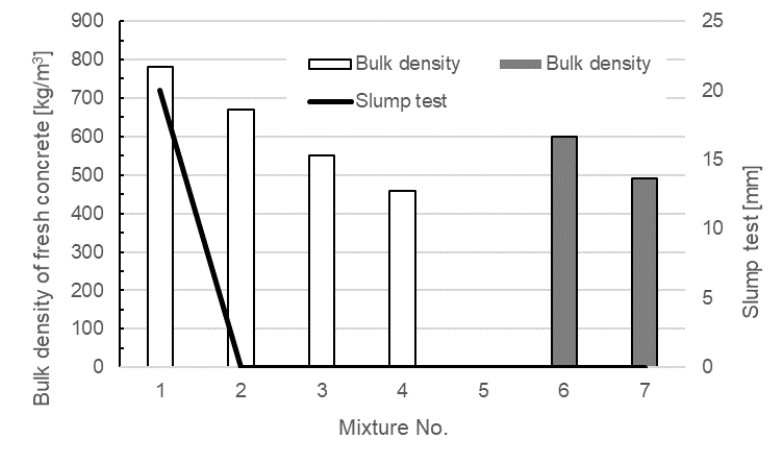
Figure 2. Bulk density and consistency of fresh lightweight concrete.